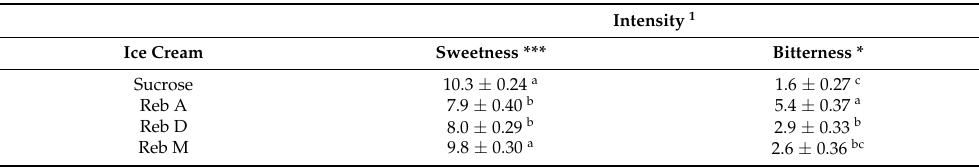
Table 7. The means ± standard error for sweetness and bitterness intensities as rated by the consumer panel for sucrose, Reb A, D, and M ice cream samples ( n =